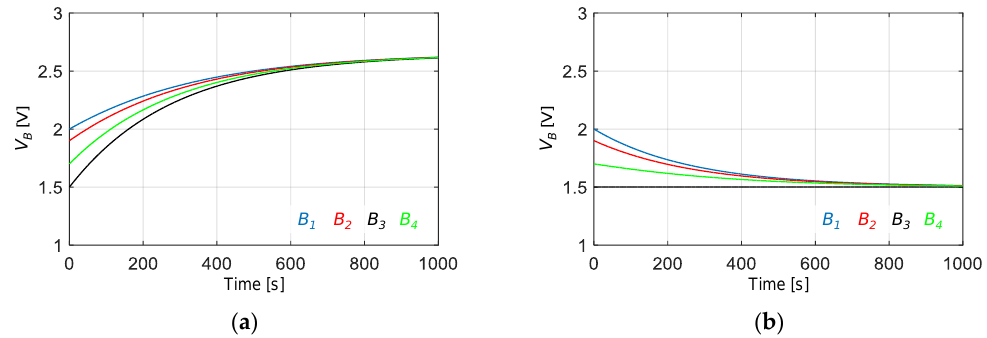
Figure 7. Electric double-layer capacitor (EDLC) cell voltage, charged by the open-loop multi-port SC converter; ( a ) the SIMO configuration with a 3.4 V voltage source; and ( b ) the MISO configuration with a 0.75 V voltage source.